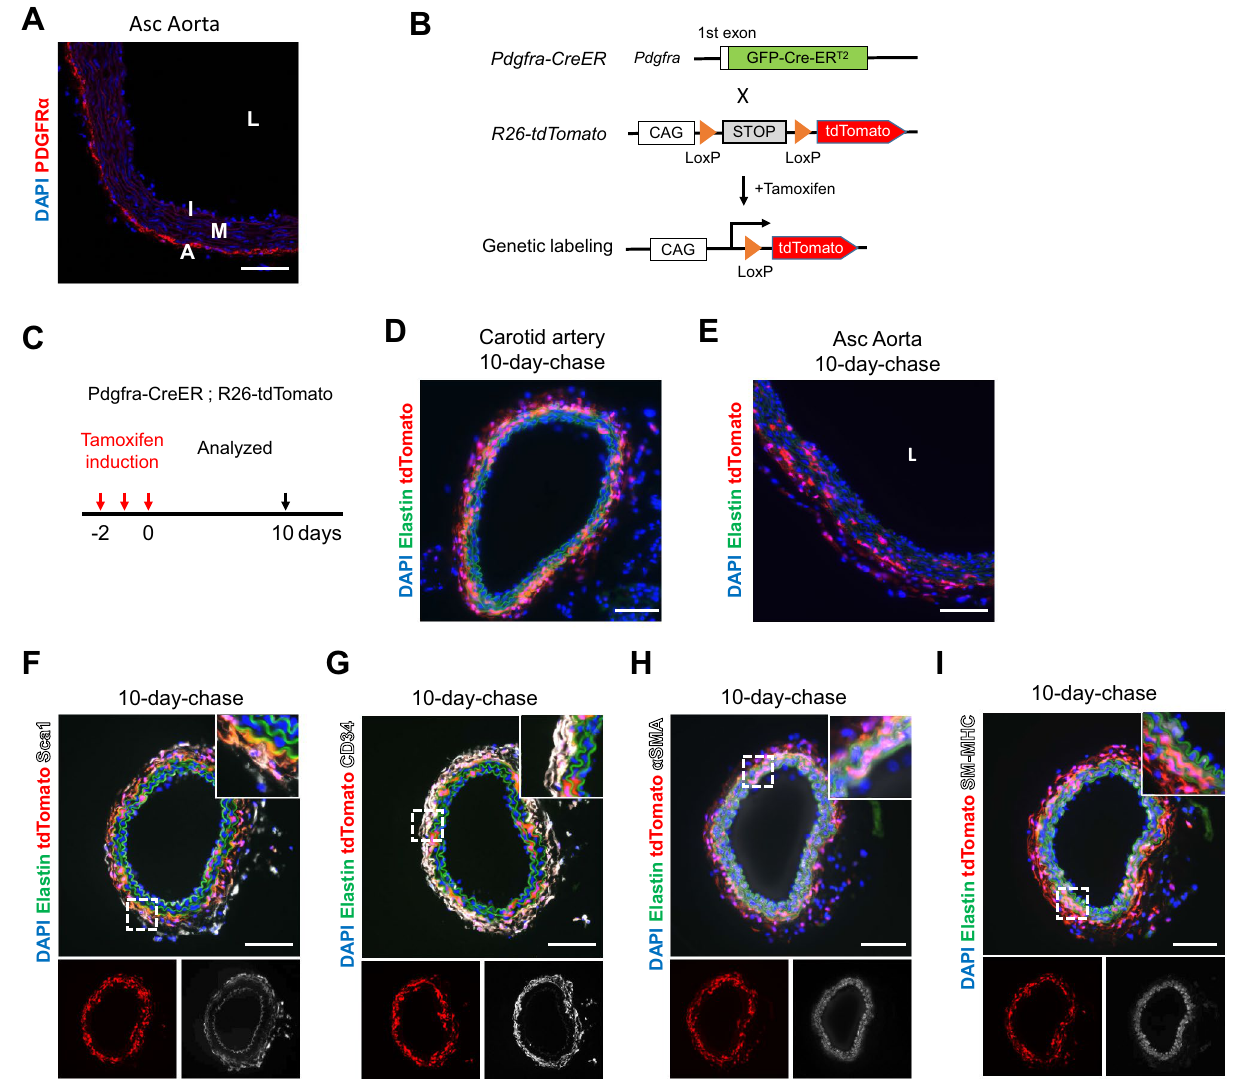
Figure 1. Genetic labeling of PDGFRa+ cells in the carotid artery. ( A ) Immunostaining for PDGFRa in the mouse ascending aorta at 2 months of age. Scale bar: 100 µm. ( B ) Schematic showing genetic lineage tracing via Pdgfra-CreER . To express the fusion protein instead of endogenous PDGFRα, the cDNA of green fluorescent protein (GFP), Cre recombinase (Cre), and mutated estrogen receptor ligand-binding domain (ER T2 ) was inserted into the translational start site of the PDGFRα locus. ( C ) Schematic outlining the experimental strategy. ( D , E ) Representative images of the initial labeling of tdTomato+ cells in the carotid artery ( D ) and ascending aorta ( E ) at 10-day-chase after tamoxifen administration. Asc Aorta: ascending aorta. Scale bars: 100 µm. ( F – I ) Immunostaining for Sca1 ( F ), CD34 ( G ), αSMA ( H ), and SM-MHC ( I ) on carotid artery sections from 10-days-chase. The dotted box area is shown in the inset with higher magnification. Scale bars: 100 µm. See also Figures S1 and